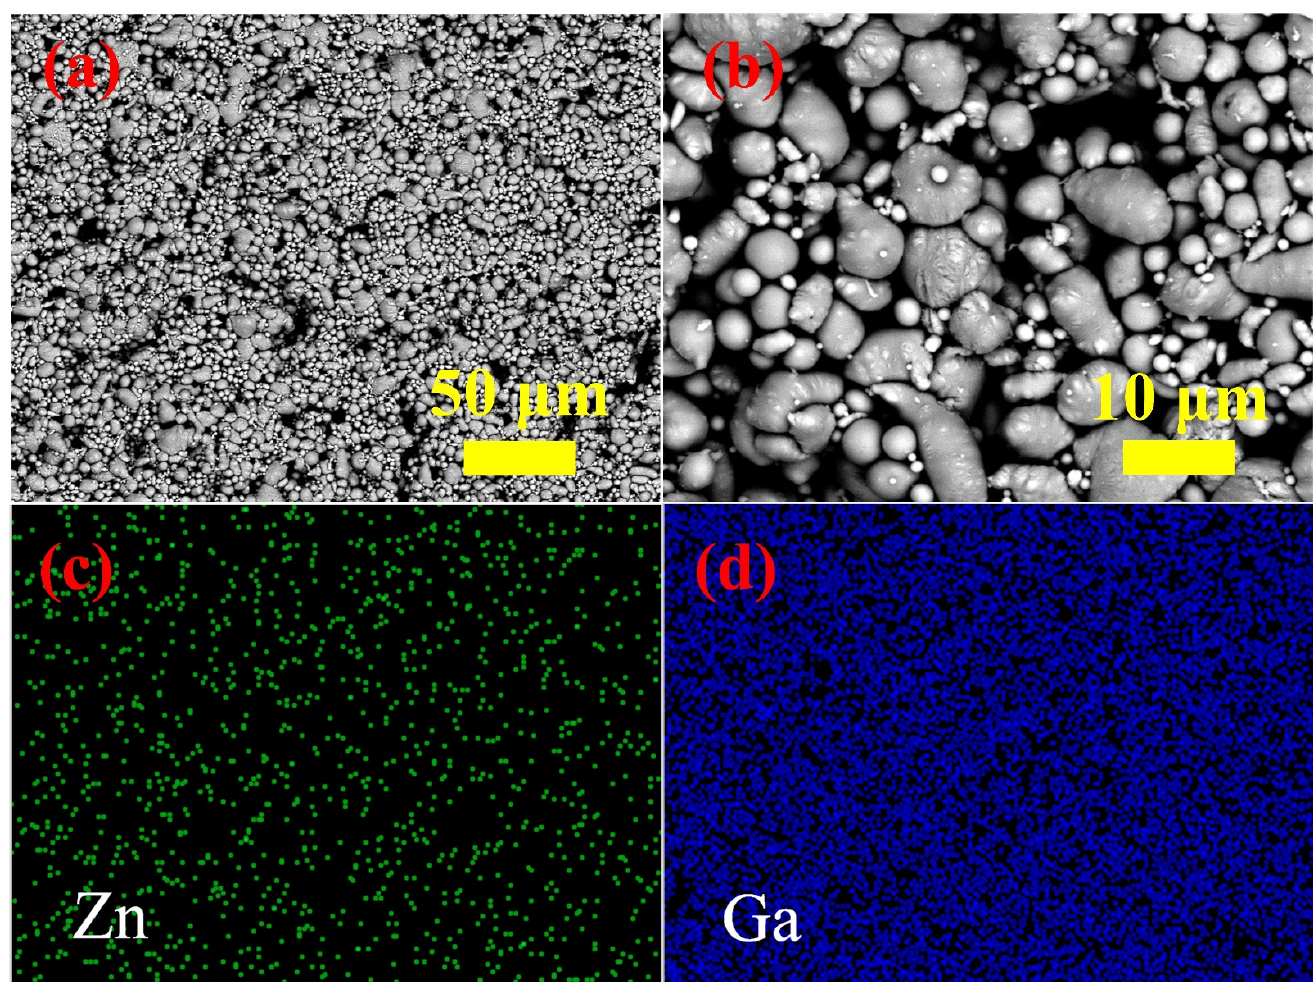
Figure 3. ( a ) SEM morphology of the Ga 2 O 3 /ZnO, ( b ) SEM morphology of the Ga 2 O 3 /ZnO at greater magnification, ( c ) the elemental mapping of Zn, and ( d ) the elemental mapping of Ga.